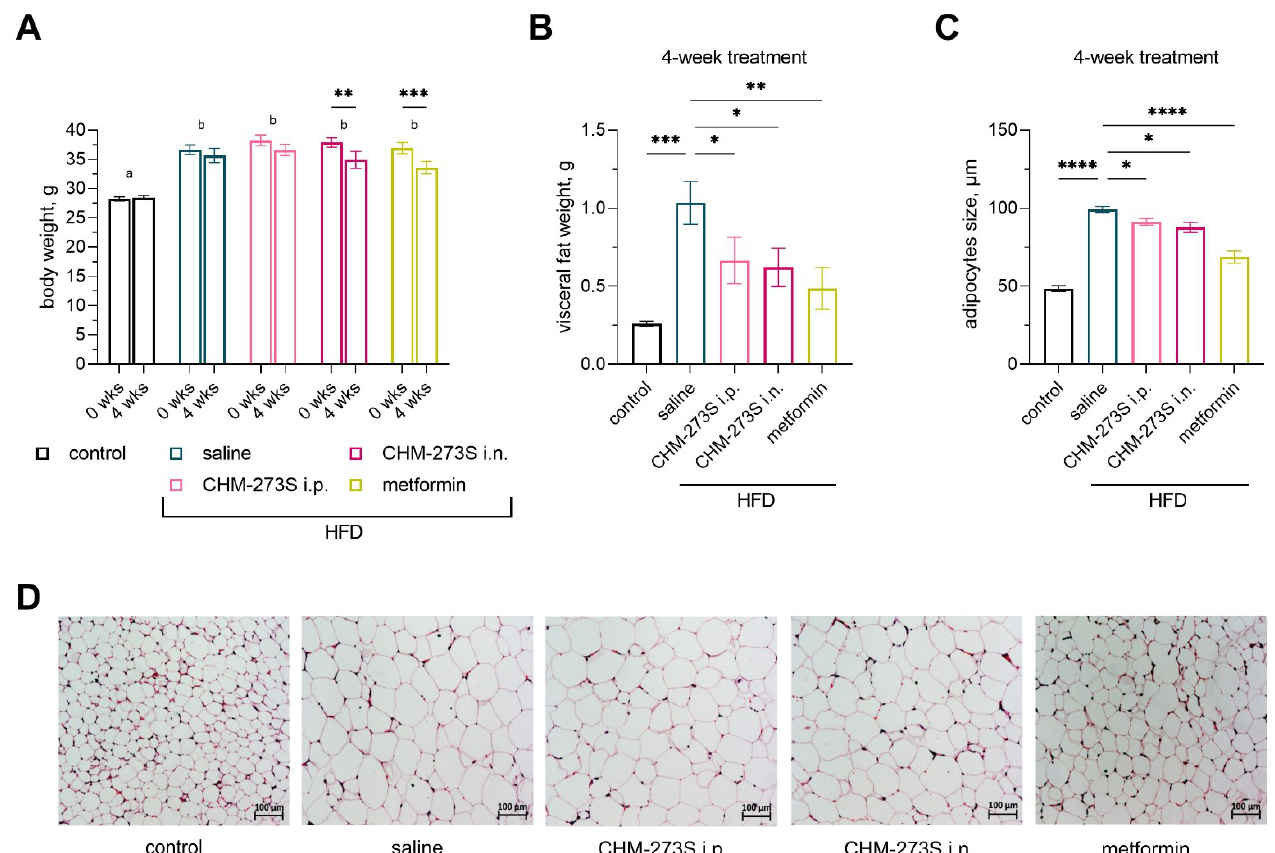
Figure 10. Body weight, visceral fat pad weight, and histological analysis of visceral adipocytes of mice fed the high-fat diet (HFD) after 4 weeks of treatment with CHM-273S (5 mg/kg, intraperitoneally (i.p.) or intranasally (i.n.), n = 10 each) or metformin (250 mg/kg perorally (p.o.), n = 10). ( A ) Body weight showed significant treatment (F (4,45) = 18.4, p < 0.0001) and time (F (1,45) = 23.31, p < 0.0001) main effects and a significant treatment × time interaction (F (4,45) = 3.21, p = 0.02). HFD-fed mice had excess weight compared with control animals fed a standard diet. The body weight of animals that received i.p. CHM-273S or metformin significantly decreased after 4-week treatment. ( B ) Excess visceral fat surrounding the testes and ( C ) the enlargement of adipocytes in HFD-fed mice was less pronounced when animals were treated with either CHM-273S (i.n. or i.p.) or metformin (F (4,45) = 5.7, p = 0.0009 and F (4,45) = 57.7, p < 0.0001, respectively). The results are presented as the mean ± standard error of the mean. Different superscript letters indicate significant differences at p < 0.05. * p < 0.05, ** p < 0.01, *** p < 0.001, **** p < 0.0001 versus the HFD-fed, saline-treated group; repeated measures analysis of variance (ANOVA) (body weight) or one-way ANOVA (visceral fat pad weight and adipocyte size) with the Holm –Šídák multiple comparisons test. ( D ) Representative histological images of visceral adipocytes.